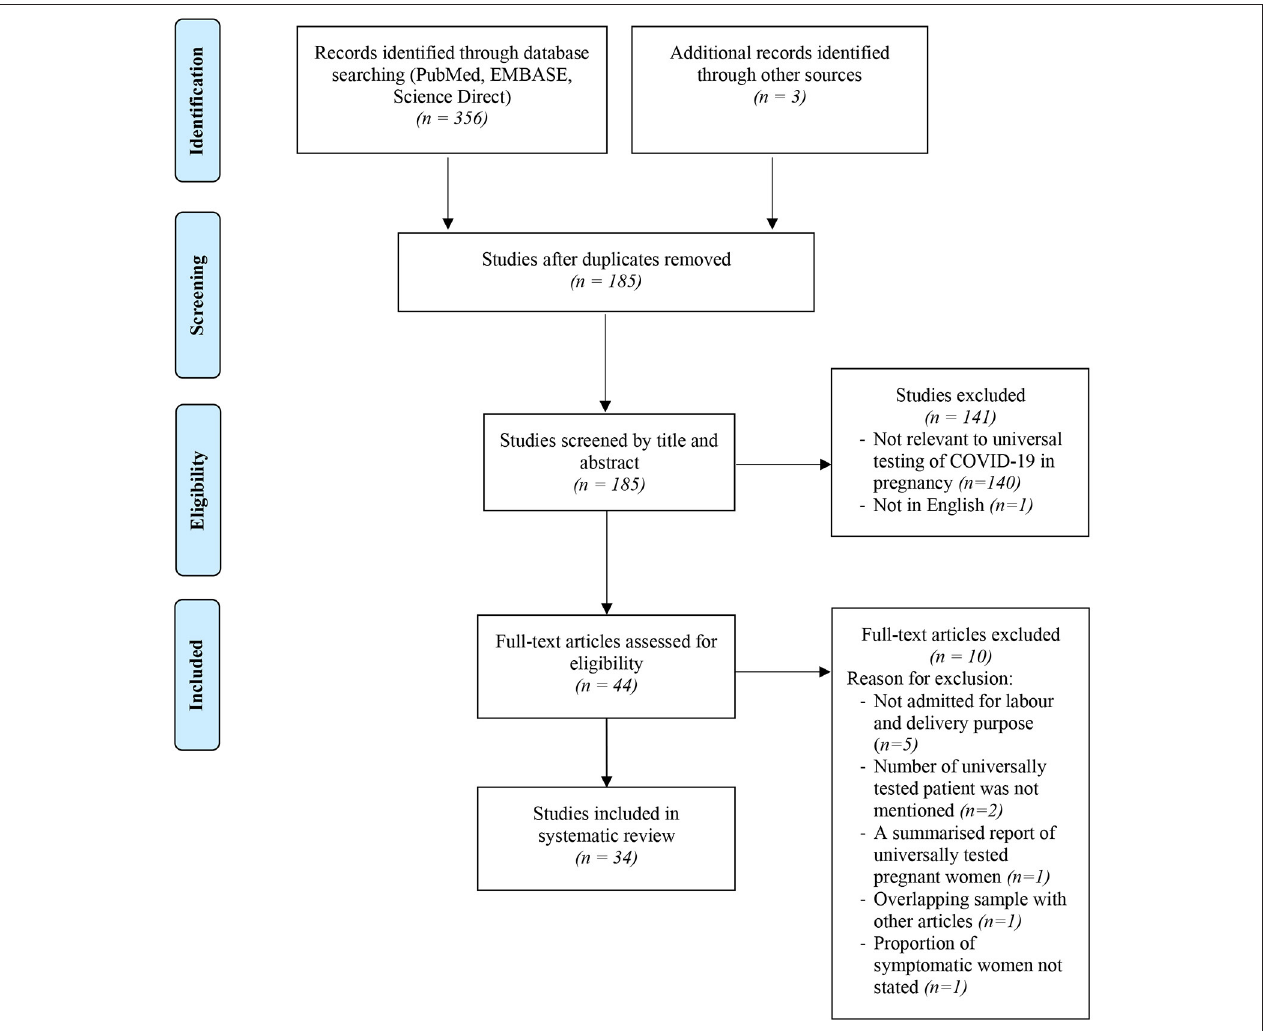
FIGURE 1 | Flowchart showing inclusion in systematic review of studies reporting on prevalence of universal testing policy for COVID-19 in pregnant